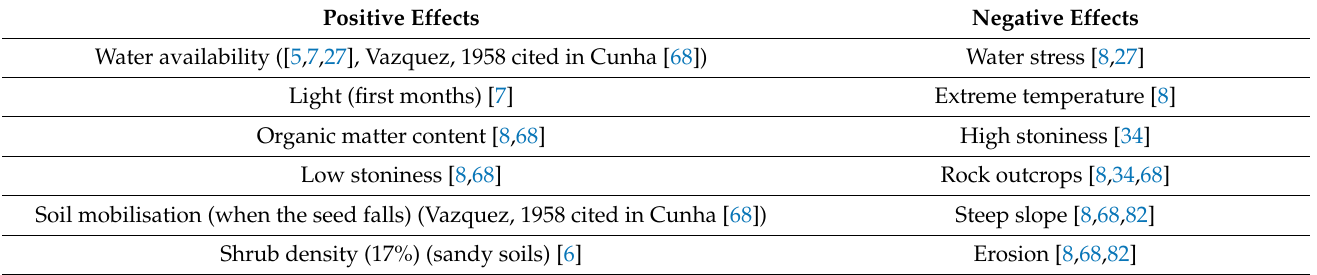
Table 2. Ecological factors influencing the natural regeneration of maritime pine. Phase: